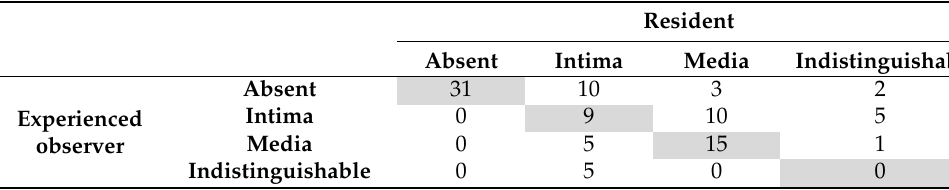
Table 3. Inter-observer agreement for